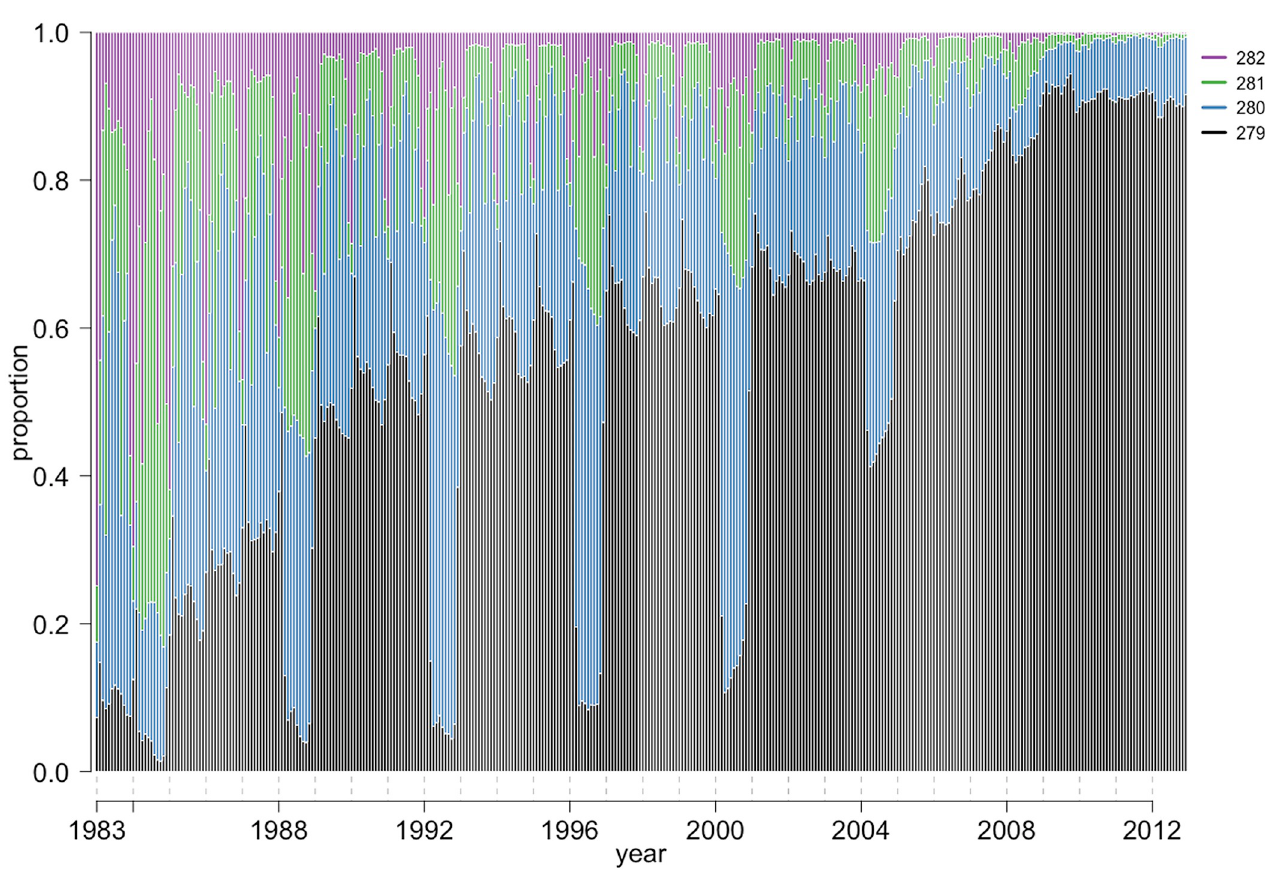
Fig 6. Interval (days) between the LMP and due date for babies born from 1983 to 2012, Swedish Medical Birth Register, 1983–2012. Most common intervals in days (from 279 to 282 days), between LMP and LMP-based due date for a baby born in a given month during 1983 to 2012. Sample size: n = 2 480